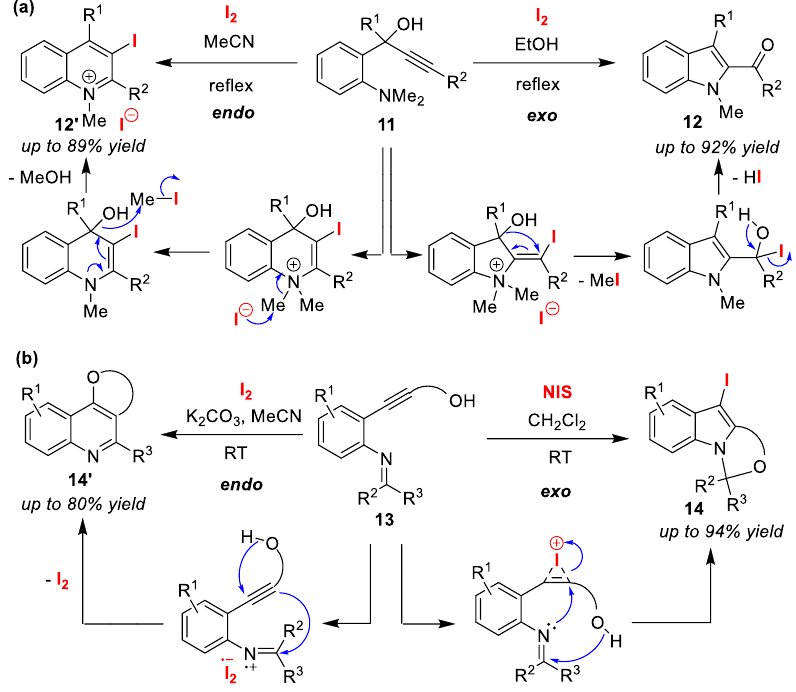
Figure 7. Endo/exo selective iodo-amino-cyclizations of ( a ) N , N -dimethylaniline with a propargyl Figure 7. Endo / exo selective iodo-amino-cyclizations of ( a ) N , N -dimethylaniline with a